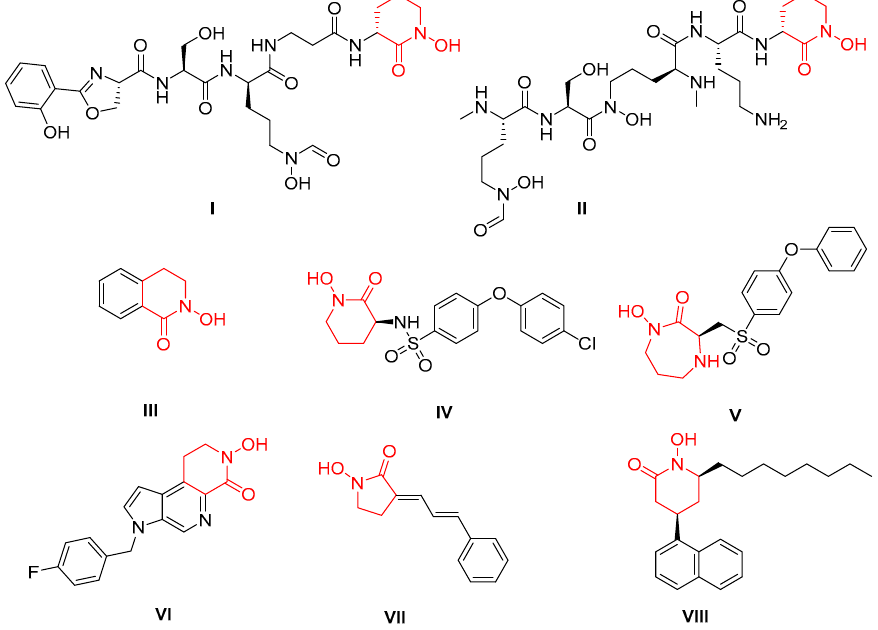
Figure 1. Examples of N -hydroxylactams whose biological activity is exerted via metal chelation.